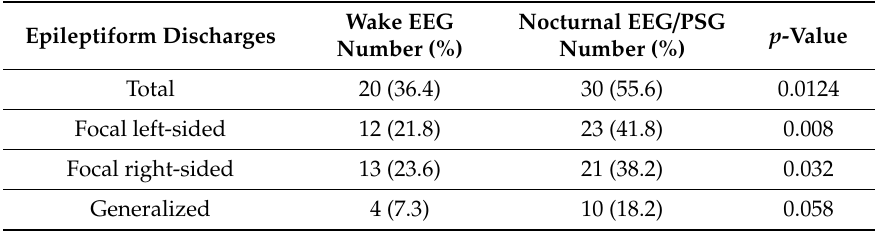
Table 2. Epileptiform discharges: Wake EEG and overnight sleep EEG / PSG ( n = 55).